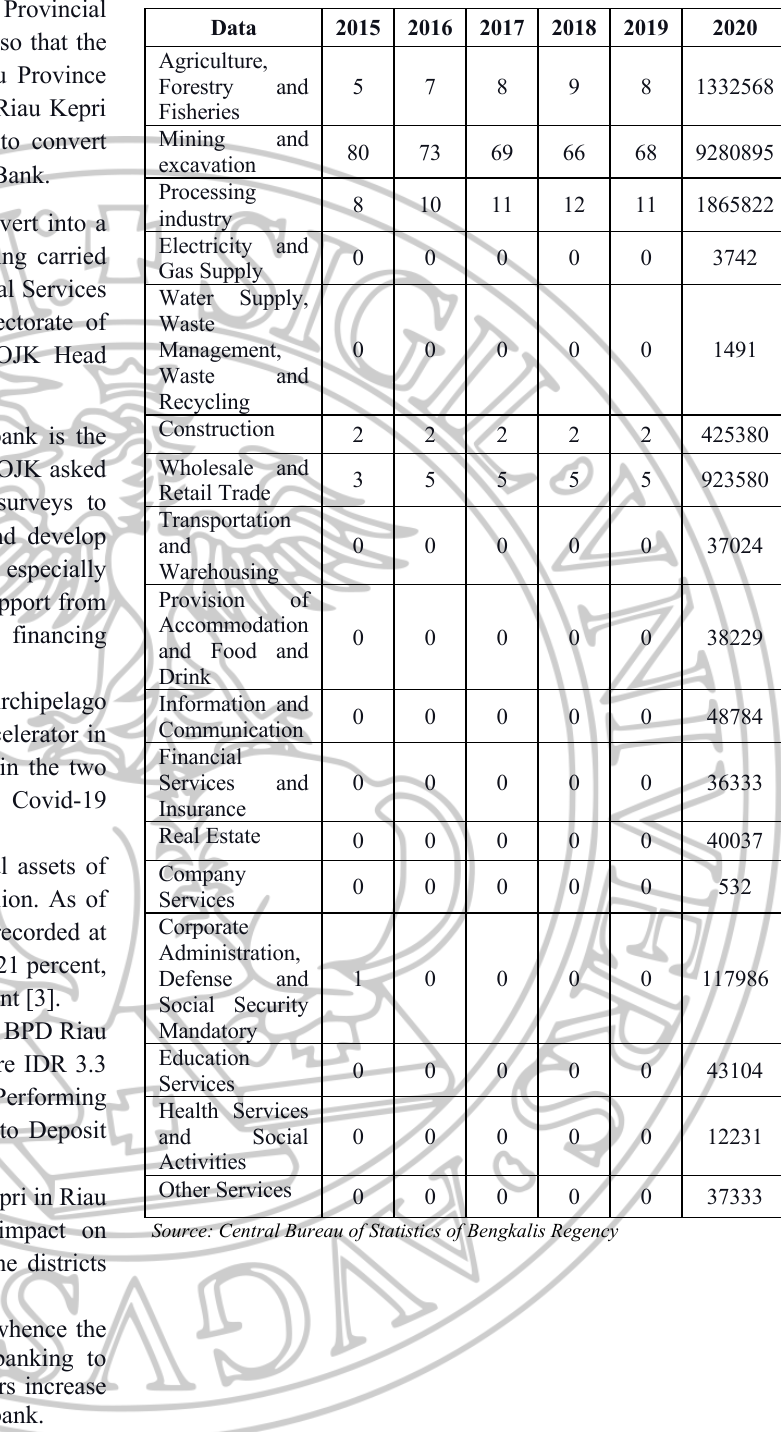
TABLE 1. BENGKALIS REGENCY ECONOMIC STRUCTURE